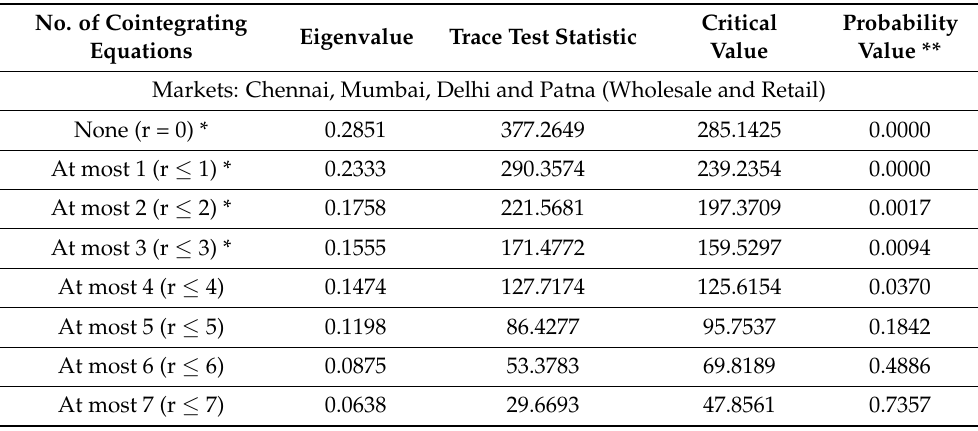
Table 9. Estimates of Johansen’s cointegration analysis of wheat markets under structural break (Assumption: Linear deterministic